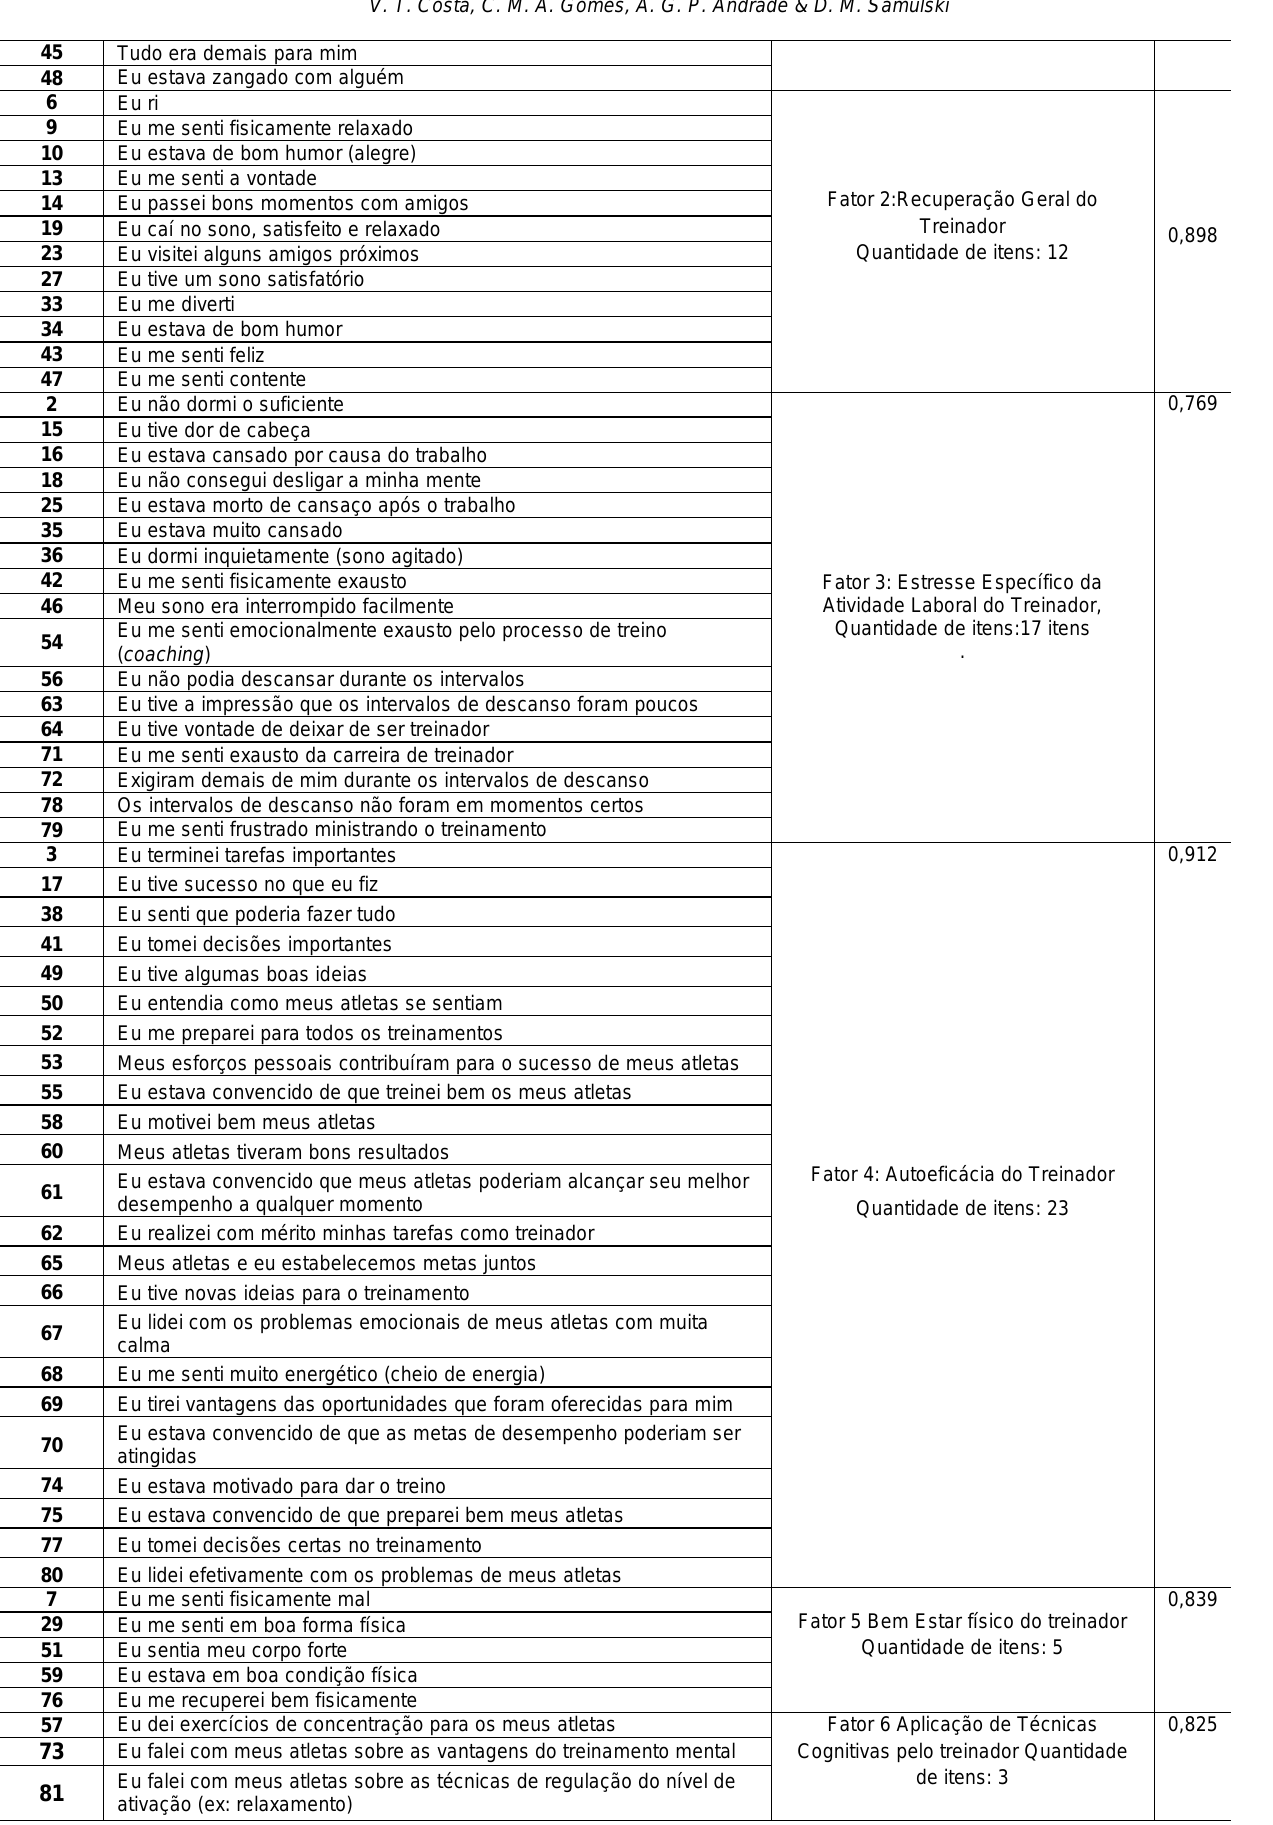
Fator 4: Autoeficácia do